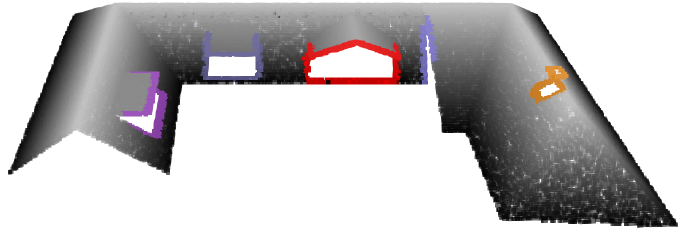
Figure 3. Detected height jumps for the first building point set on the left in Figure 2b, where points of each height jump are